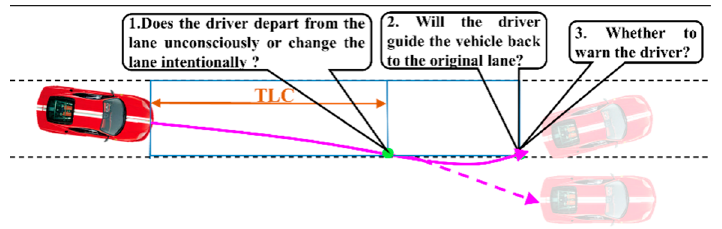
Figure 1. Identification process of driver’s unconscious lane departure behavior.